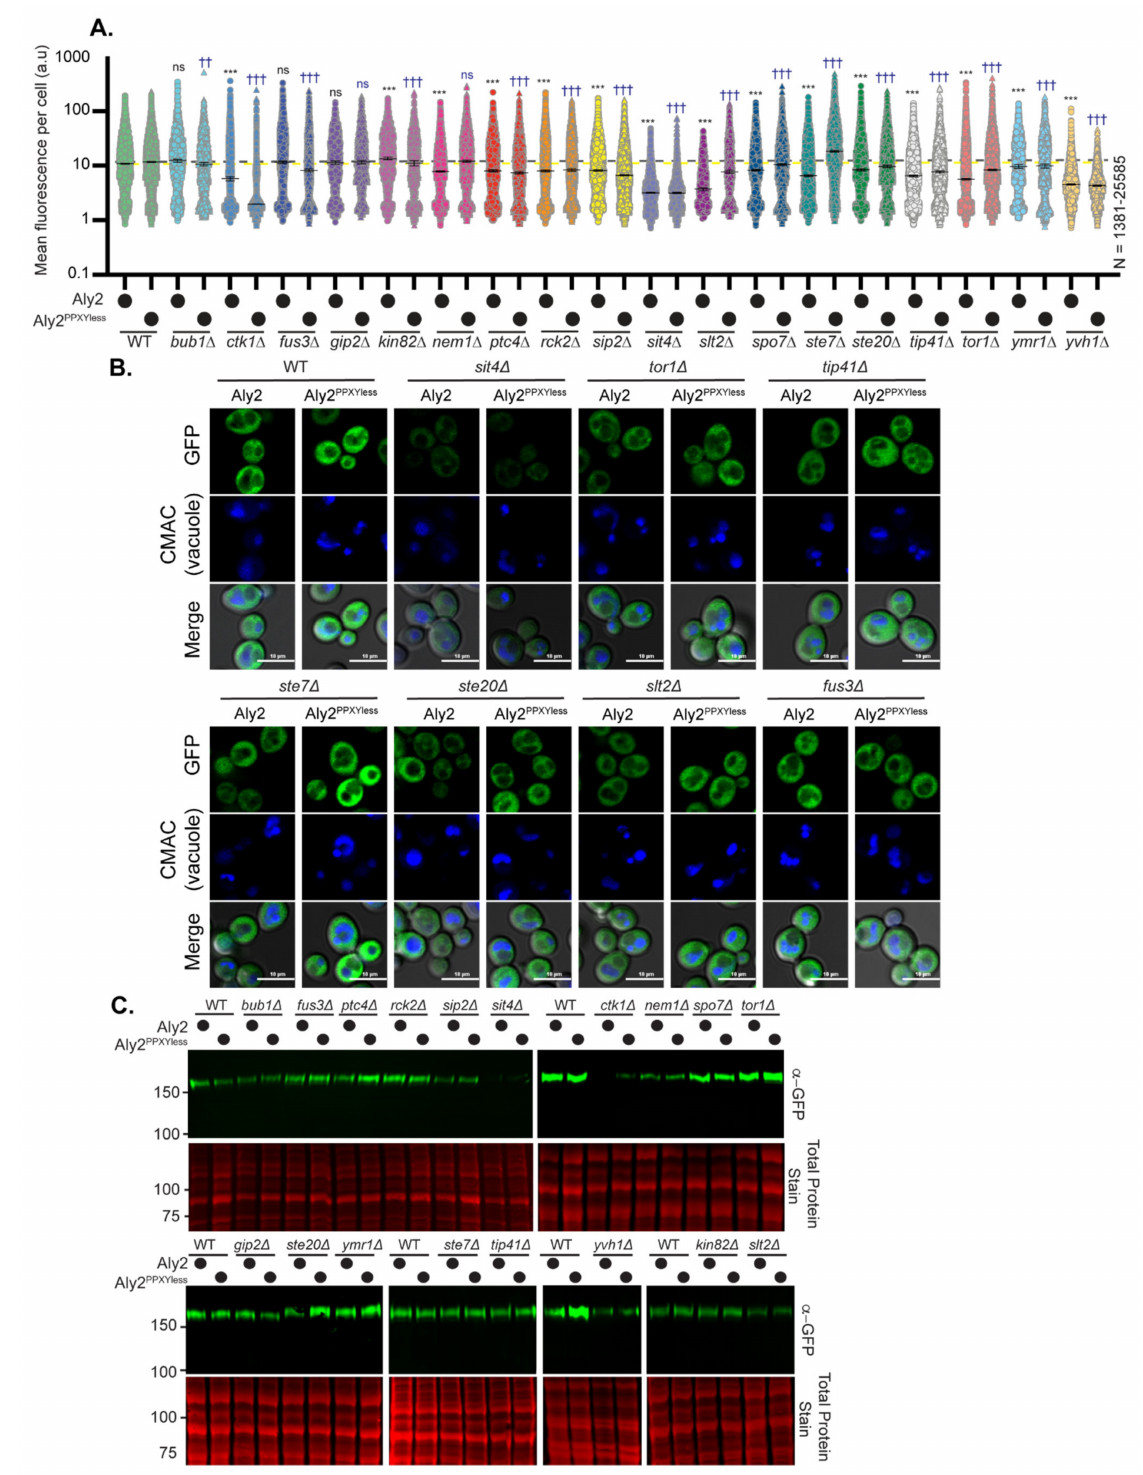
Figure 4. Kinases and phosphatases from the KinDel screen alter the abundance and electrophoretic mobility of Aly2: ( A ) Cells expressing the indicated Aly2 protein fused to GFP (pRS415- TEF1pr plasmids) in either WT or the noted gene deletion backgrounds were imaged by high-content confocal microscopy, and whole-cell fluorescence of the cells was quantified using NIS. ai and